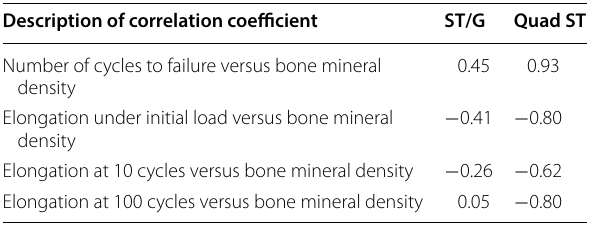
Table 3 Correlation of measured variables versus bone mineral density Description of correlation